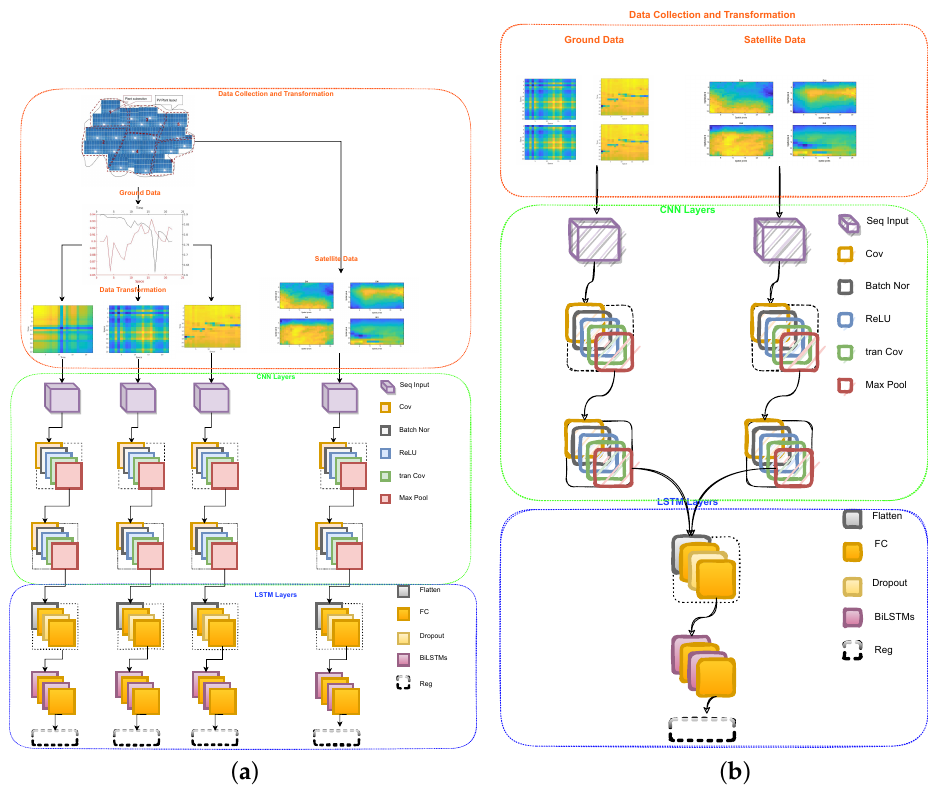
Figure 4. The DNN model networks’ structure with GD, Sat, and Sat-GD data as the input: ( a ) The framework of the CNN-LSTM model. ( b ) The framework of the MCNN